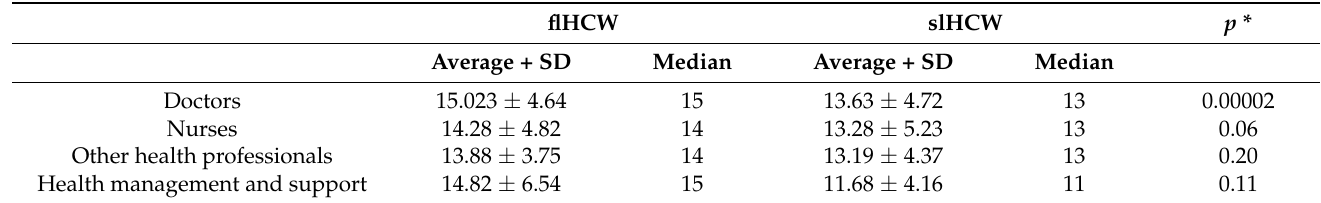
Table 7. Comparison of the exhaustion scores in frontline healthcare workers and in the control group by occupation.